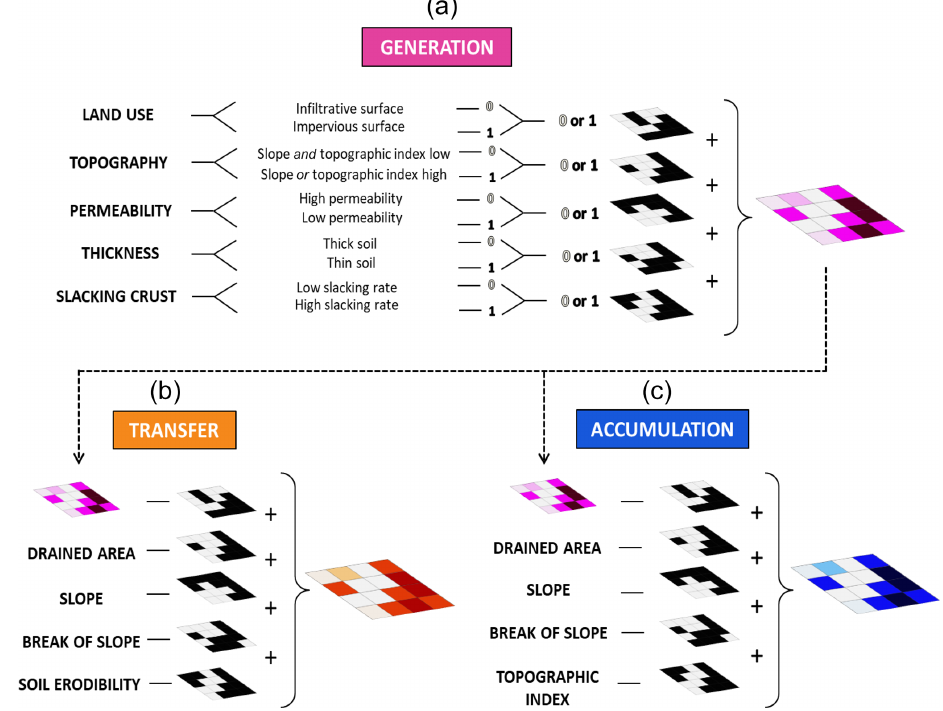
Figure 1. Scheme of the IRIP model presenting the various indicators computed to produce the susceptibility maps to runoff generation (a) , transfer (b) and accumulation (c) (adapted from Lagadec et al., 2018).